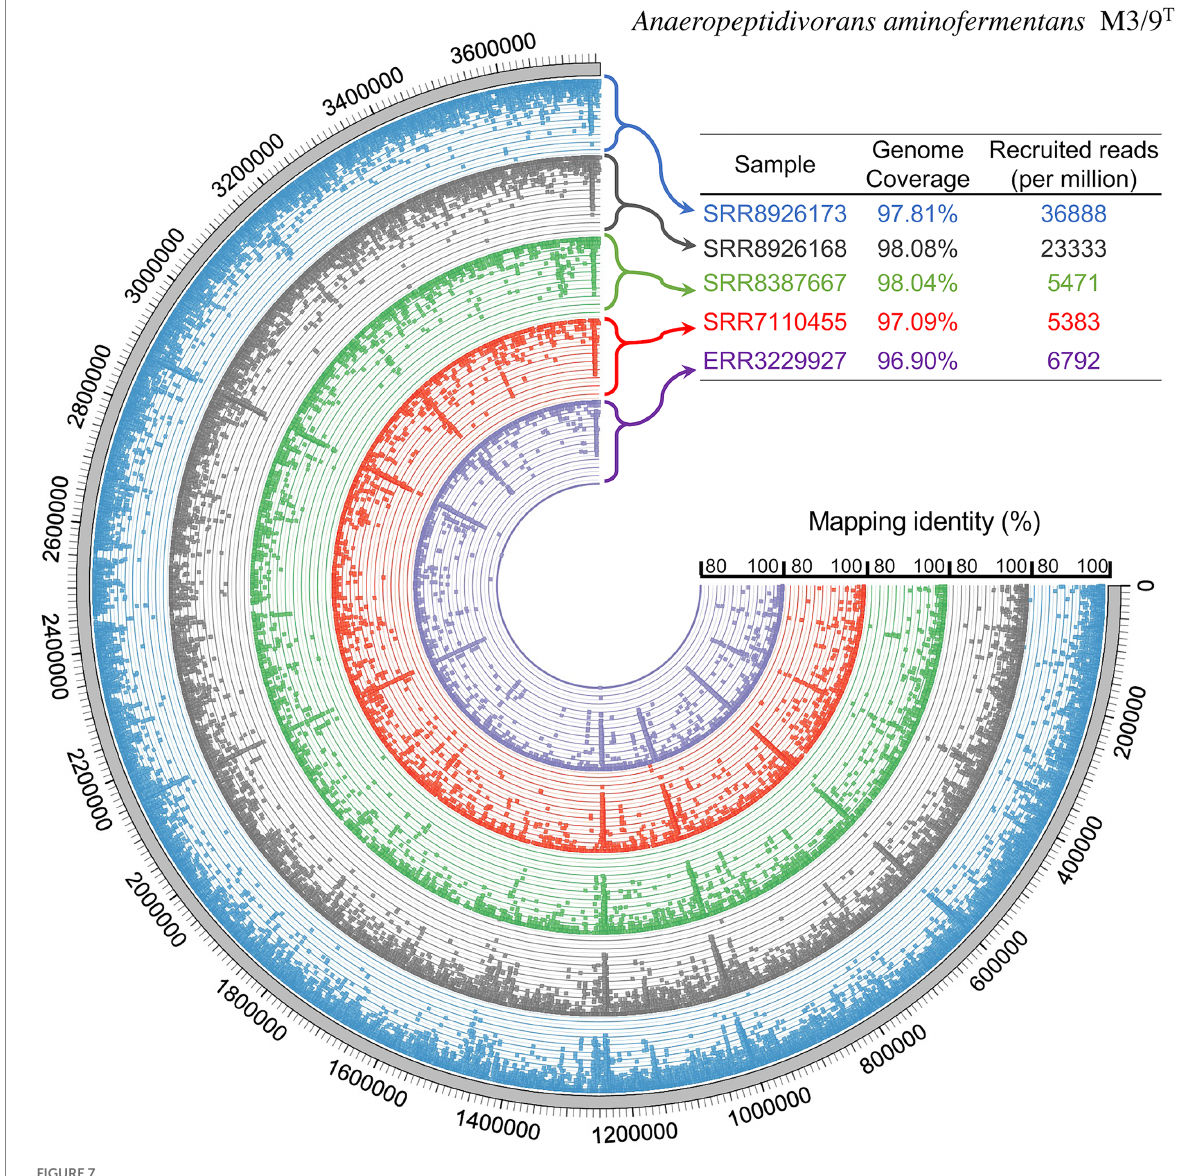
a mapping identity of at least 95%. The outer ring represents the genome in base pairs, while the remaining colored rings show the coverage of the corresponding metagenome sequences mapped onto the genome sequence. Sample origin: SRR8926173 and SRR8926168, human